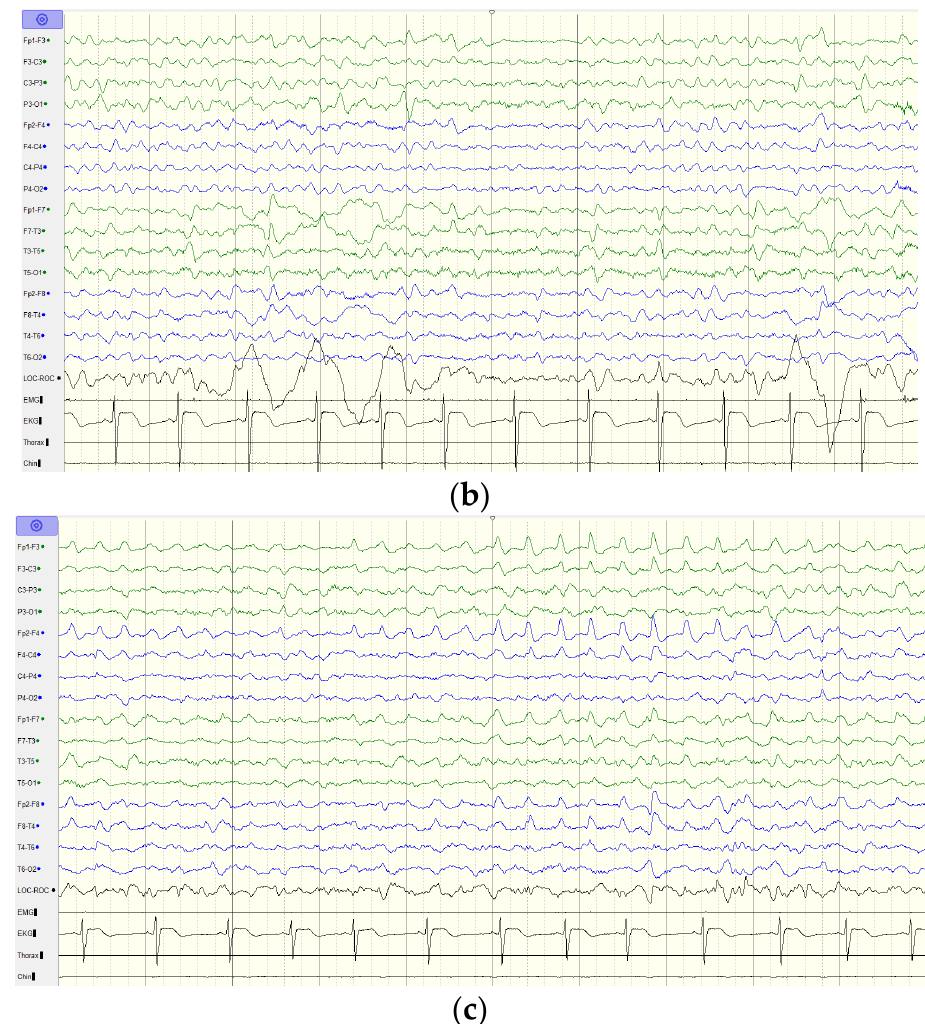
Figure 3. EEG findings of the index case. ( a ) EEG at the age of 11 years old shows generalized background slowing and continuous rhythmic 3 to 4 Hz slow waves over the left frontal, temporal, and occipital regions. ( b ) EEG at the age of 12 years old shows generalized background slowing and continuous polymorphic 4 to 5 Hz slow waves over the left hemisphere superimposed with focal spikes over T3. ( c ) EEG at the age of 13 years old shows rhythmic 3 to 4 Hz slow waves over the bilateral hemisphere. Green line indicates the left hemisphere and blue line indicates the right hemisphere.